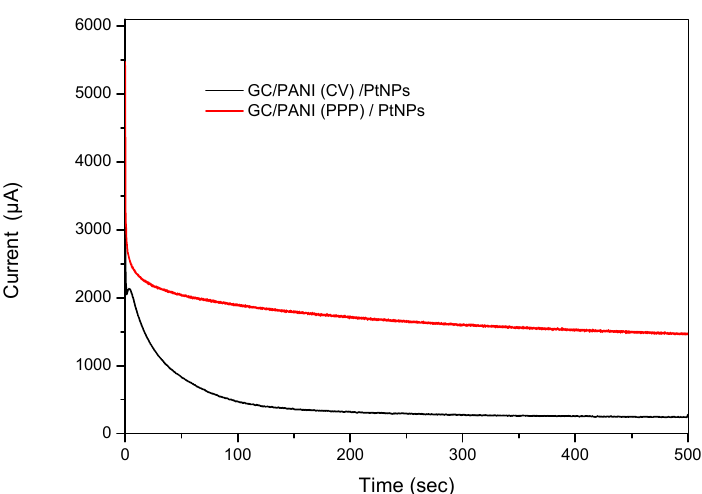
Figure 13. Chronoamperograms of the GC/PANI(PPP)/PtNPs (black) and of the GC/PANI(CV)/PtNPs electrode (red) and of a GC/PANI(CV)/PtNPs electrode in 2 M methanol +1 M H 2 SO 4 at 0.6 V.